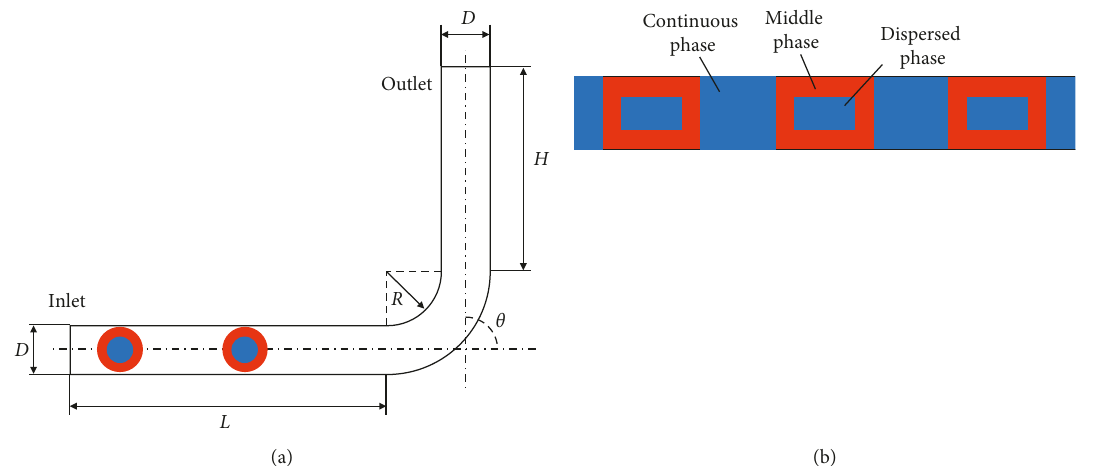
Figure 1: Schematics and computational domain of the mathematical model: (a) compound droplet deformation in the curved mini- channel; (b) compound droplet formation.